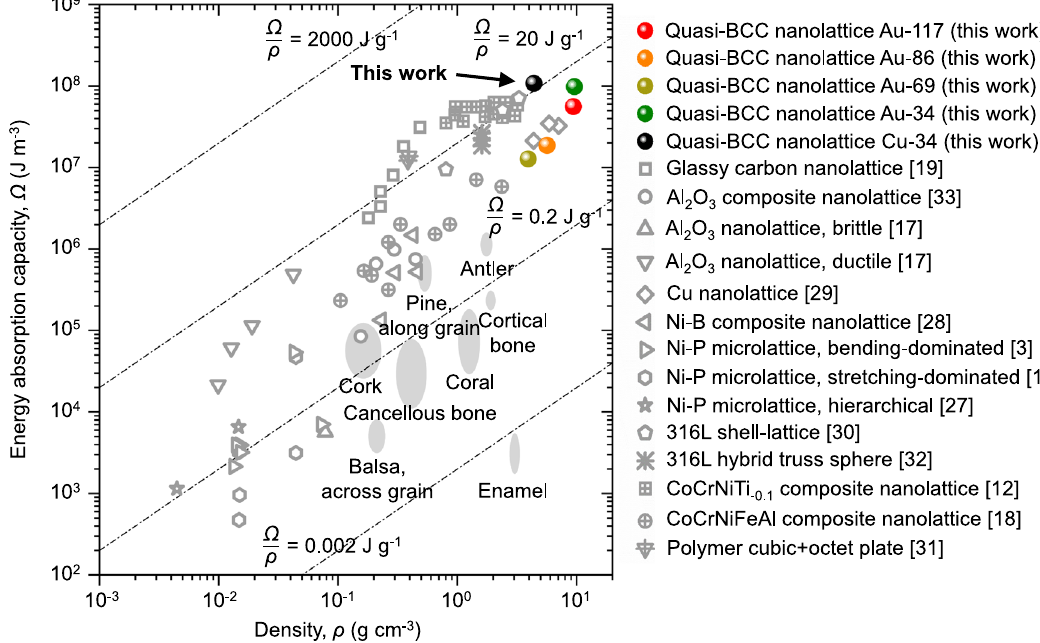
Fig. 4 | Ashby map of energy absorption per unit volume versus density of gold and copper quasi-BCC nanolattices and previously reported micro/nanolattice metamaterials. Source data are provided as a Source Data fi